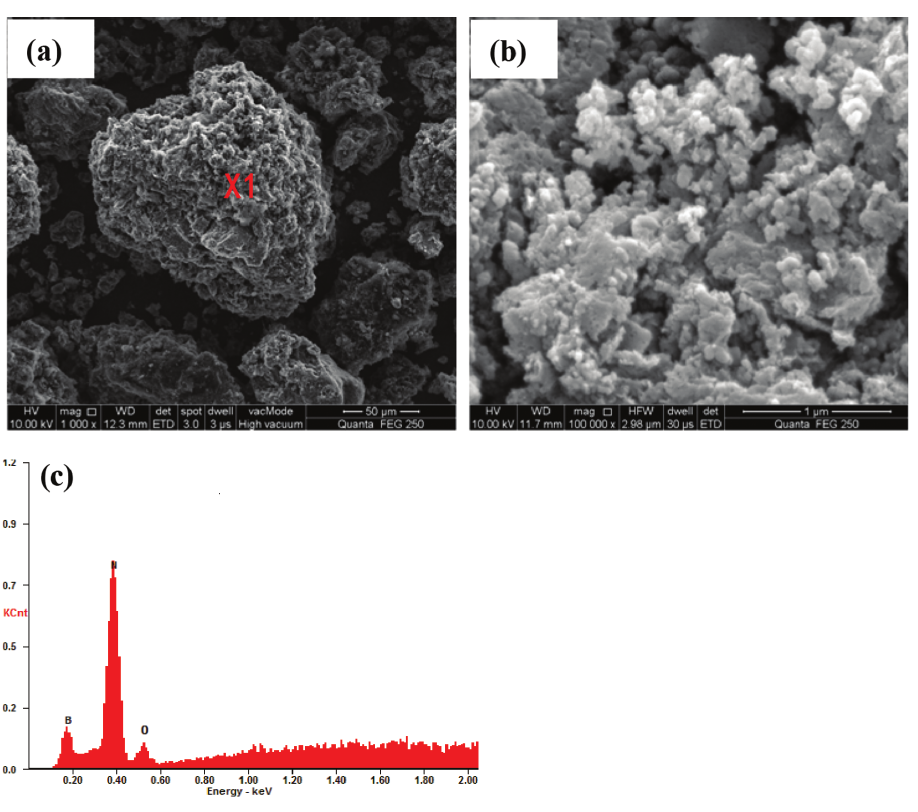
Figure 4: (a) SEM of BN(CB); (b) SEM of high magnification of X1; (c) (EDS) analysis of Figure 4 (b).